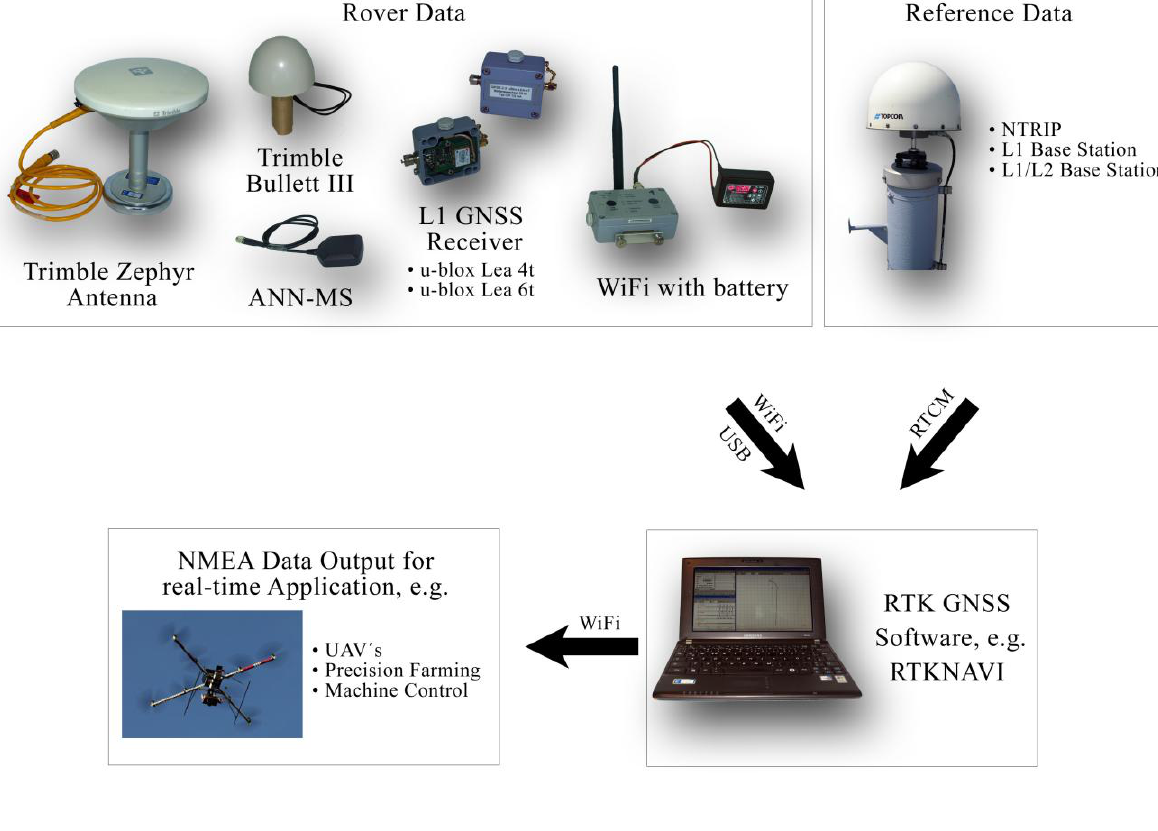
Figure 2. RTK GNSS Low-cost System